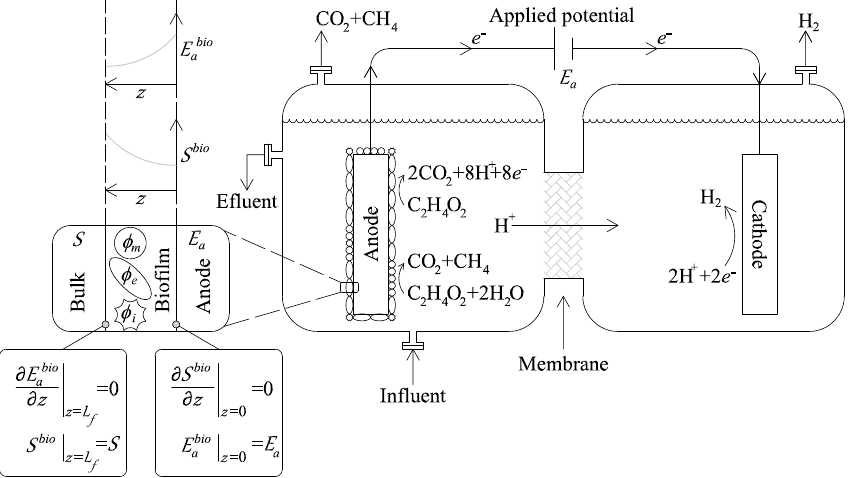
Figure 1. Biofilm schematic representation of the microbial electrolysis cell including involved boundary